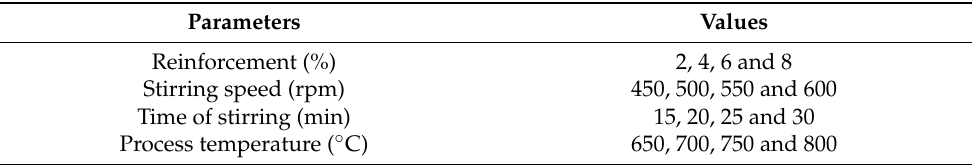
Table 4. Stir casting process parameters.